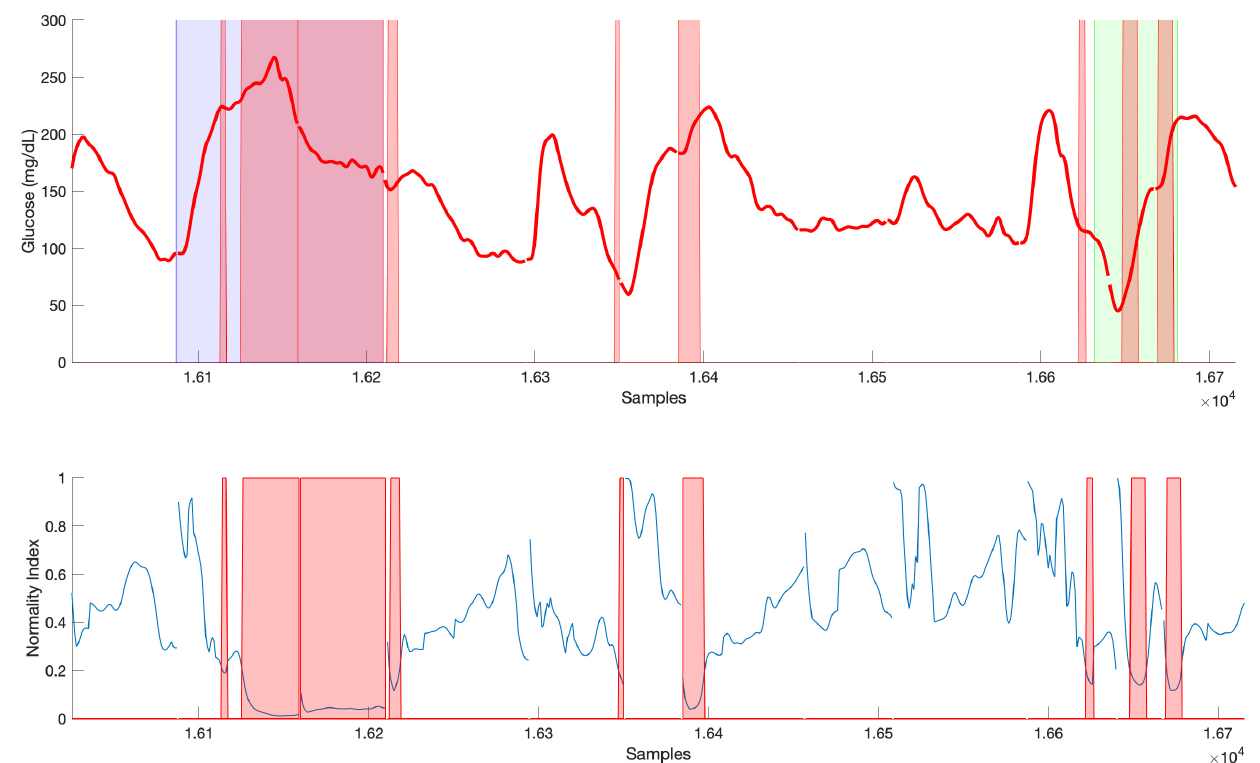
Figure 9. Example of relationship between Normality Index and abnormal events in the simulated scenario. Shaded blue area indicates a missed bolus postprandial period. Shaded green area indicates an exercise session and 3-h post-exercise period. Shaded red area indicates a section of CGM data classified as abnormal ( NI ( t p ) <